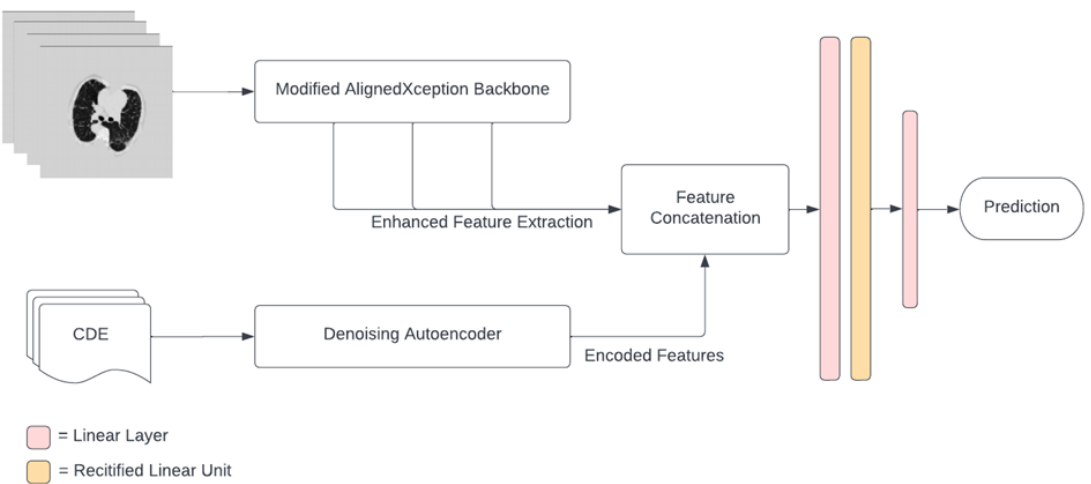
Figure 1. Model architecture schematic.